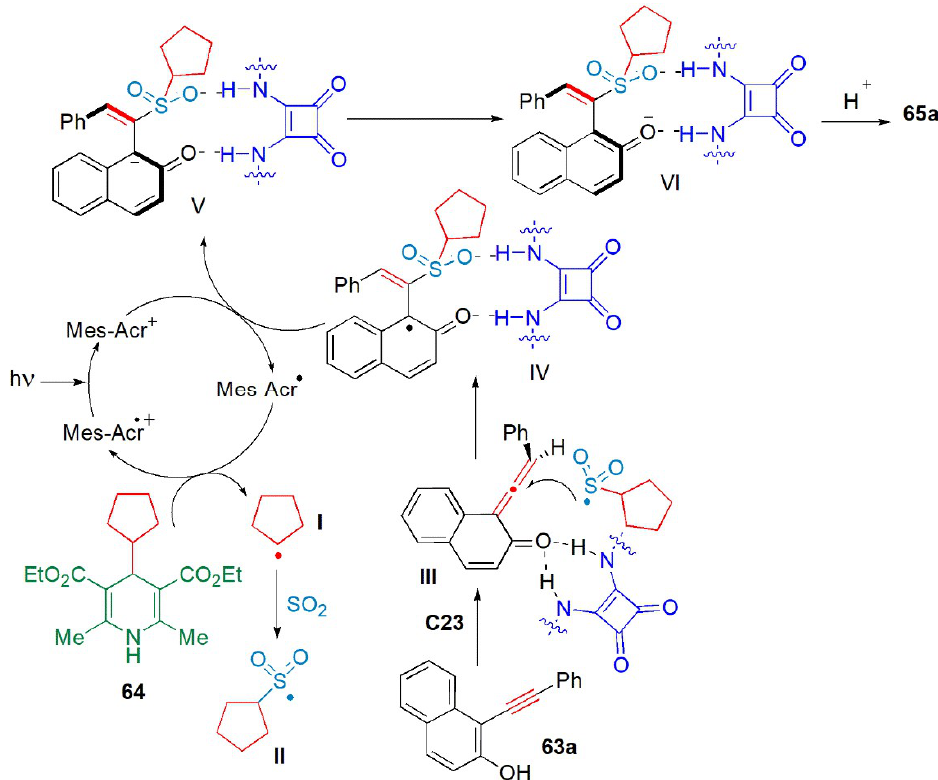
Figure 25. Mechanism proposed for the enantioselective sulfonylation of 1-(arylethynyl)naphthalen- 2-ols [96].